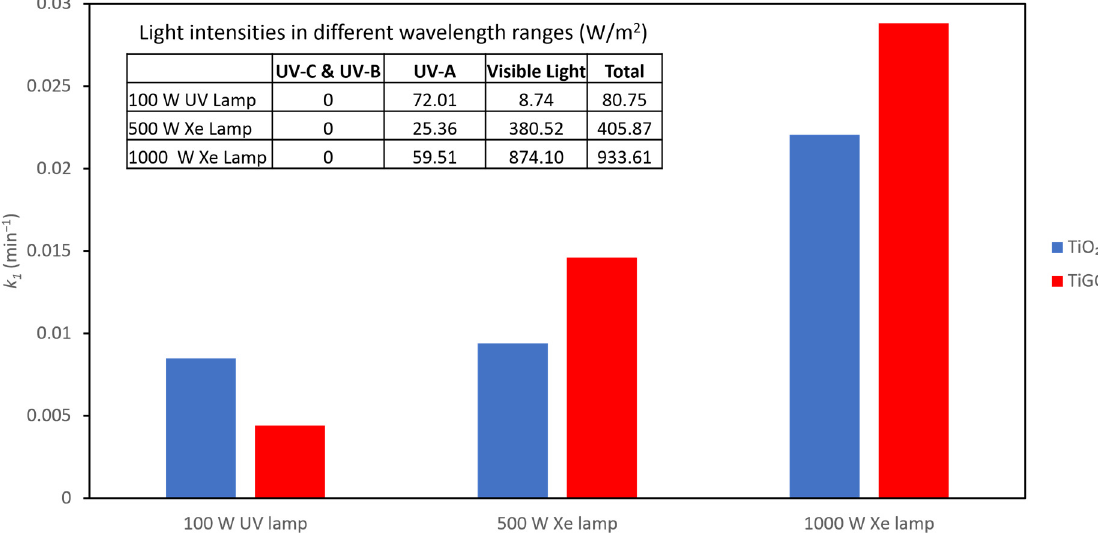
Figure 5. Pseudo first-order reaction constant k 1 of CBZ photodegradation under different light intensities. CBZ initial concentration = 1 mg/L; catalyst dose TiO 2 and TiGC (TiO 2 :GO ratio 2:1) = 0.2 mg/mL.